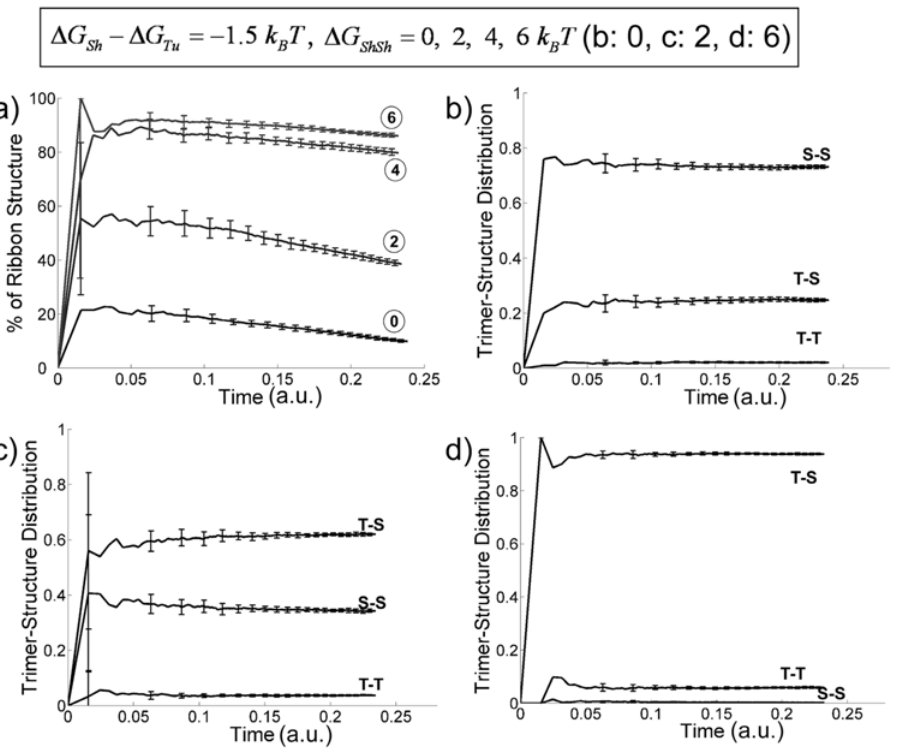
Figure 5. Effect of variable D G ShSh on the assembly structures for fixed D G Sh ~~{{ 17 k B T and D G Tu ~~{{ 15 : 5 k B T ( D G Sh {{ D G Tu ~~{{ 1 : 5 k B T v 0 ). (a) Percentage of ribbon structures as a function of time ( D G ShSh ~ 0,2,4 and 6 as indicated by circled numbers). (b) Trimer-structure distribution v.s. simulation step for D G ShSh ~ 0 . The three possible trimer structures, T-T ( tube - tube ), T-S ( tube -sheet) and S-S (sheet-sheet), are indicated in the figure. (c) Trimer structure distribution v.s. simulation step with D G ShSh ~ 2 k B T . (d) Trimer-structure distribution v.s. simulation step with D G ShSh ~ 6 k B T .